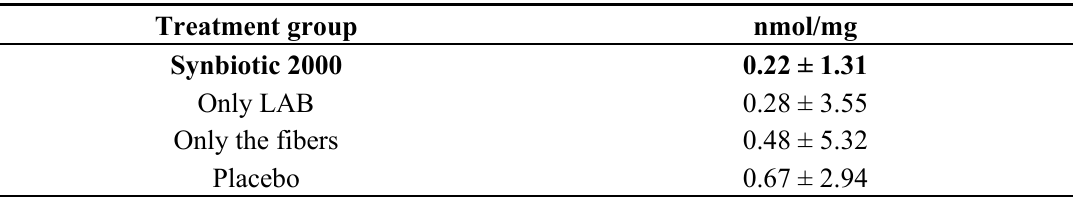
Table 3. Lipid peroxidation in the lung tissue determined expressed as levels of malondialdehyde (MDA), measured in nmol/mg protein, after treatment with Synbiotic 2000, only the LAB in Synbiotic 2000, only the fibers in Synbiotic 2000 and placebo respectively [71]; p < 0.05.